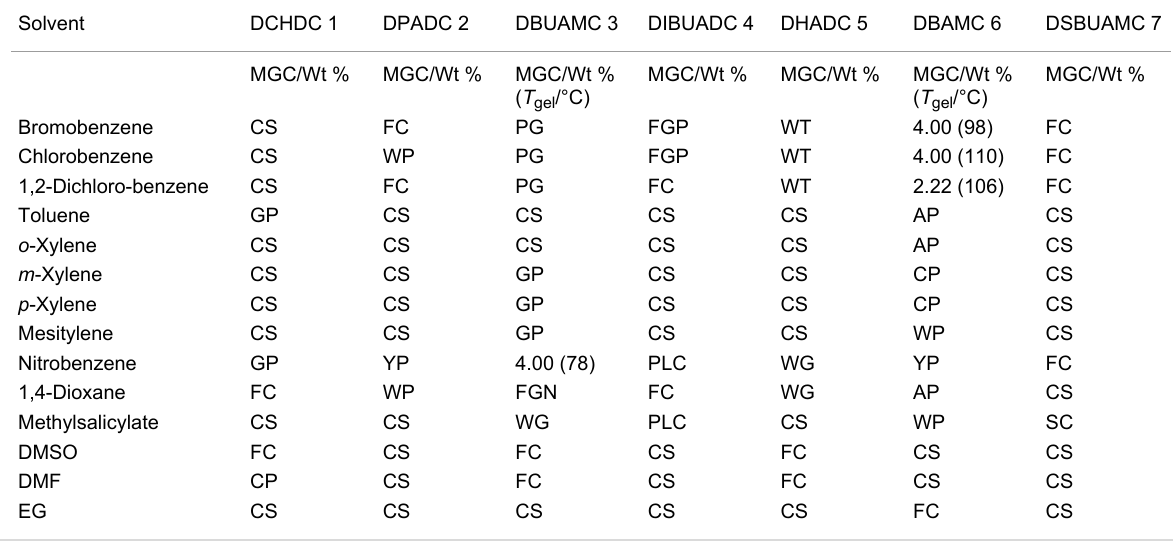
Table 1: Gelation data (CS = Clear solution, GP = Gelatinous precipitate, FC = Fibrous crystal, CP = crystalline precipitate, AP = Amorphous precipi- tate, WP = White precipitate, YP = Yellow precipitate, PG = Partial gel, WG = Weak gel, FGN = Fibrous gelatinous network, PLC = plate like crystal, WT = White turbidity).